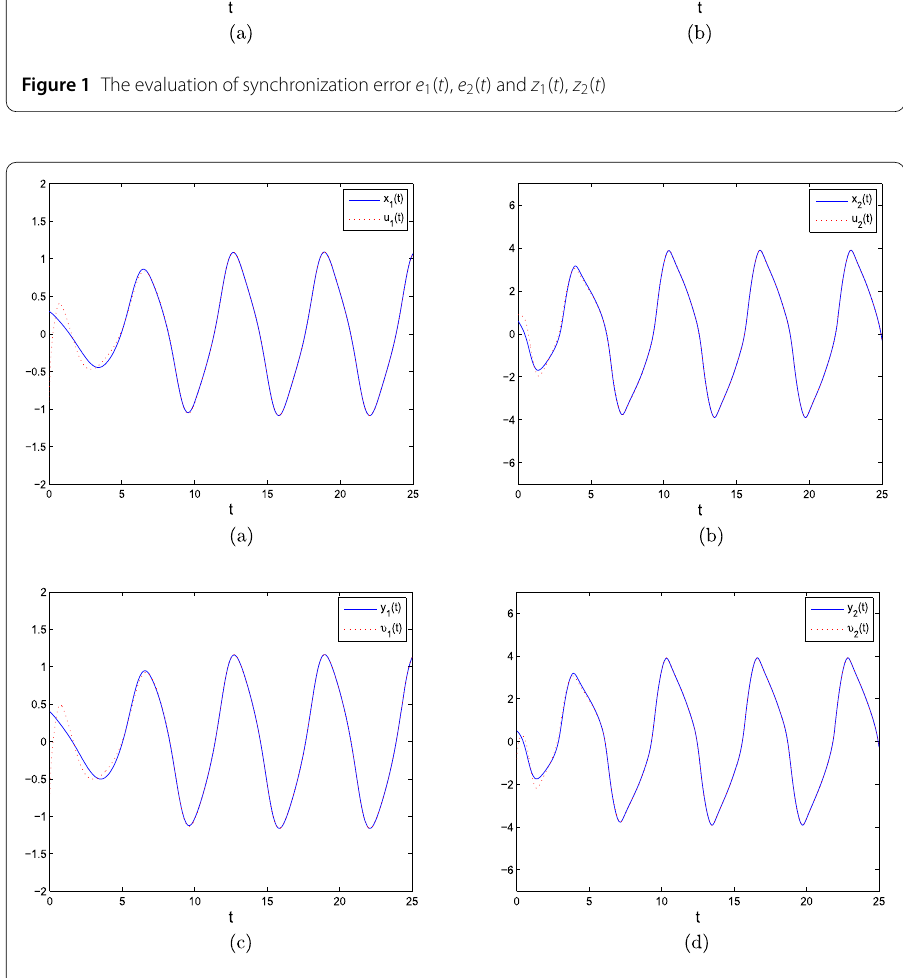
Figure 2 Synchronization curves of x 1 ( t ), u 1 ( t ), x 2 ( t ), u 2 ( t ) and y 1 ( t ), υ 1 ( t ), y 2 ( t ), υ 2 ( t )